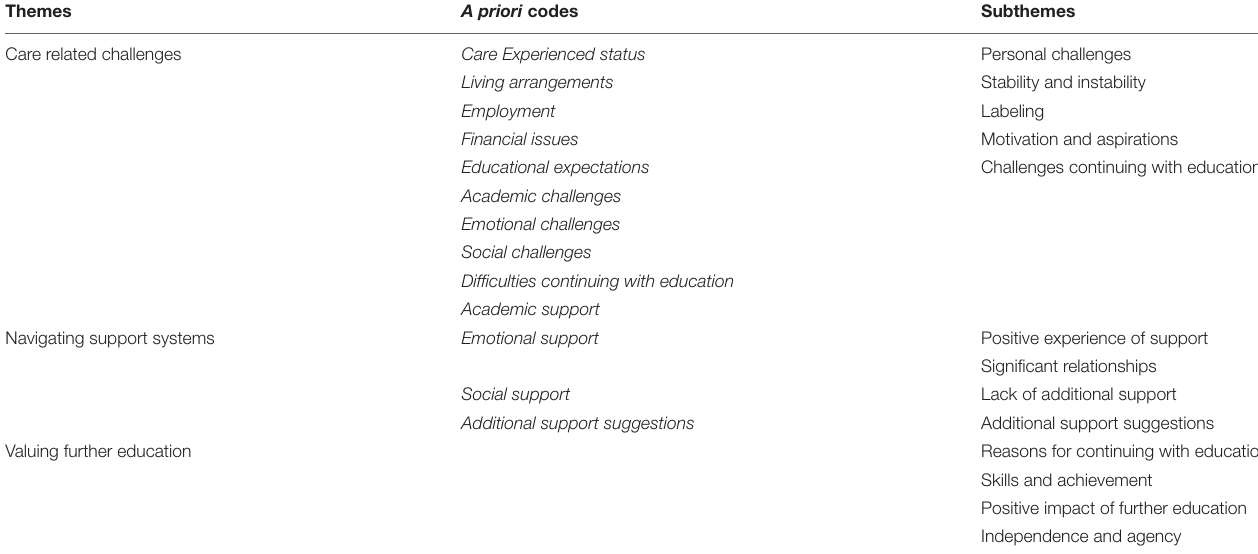
TABLE 2 | Theme development